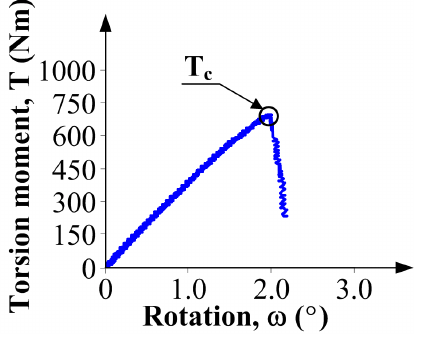
Figure 10. An example graph of torsion moment-rotation relationship obtained in the tests at mode III fracture. On the basis of the experimental results, fracture toughness (cid:1837) (cid:3010)(cid:3010)(cid:3010)(cid:3030) can be calculated, according to the Equation (5), proposed by Miannay [73].